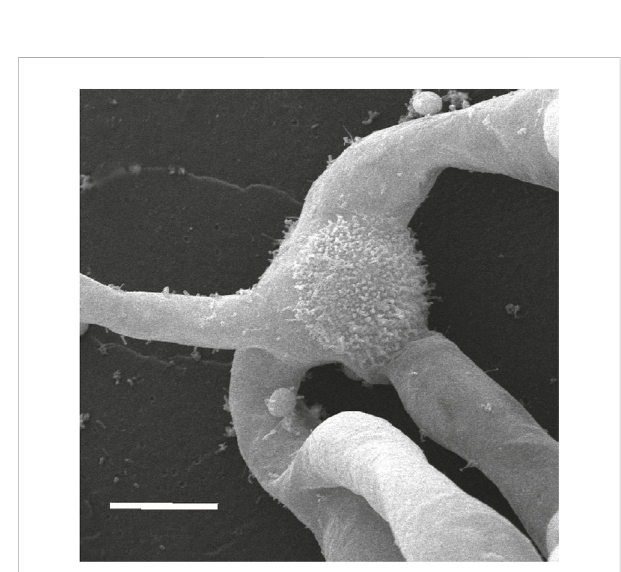
FIGURE 9 SEM of the germinated spore showing the intact distal spore wall withthreeprotonemataemergingfromtheproximalsideofthespore. Scale bar = 20 μ m.